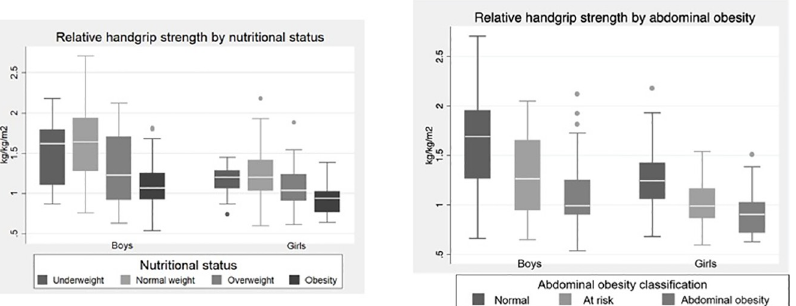
Fig 1. Relative handgrip strength (kg/kg/m 2 ) by nutritional status and abdominal obesity category among Chilean adolescents.